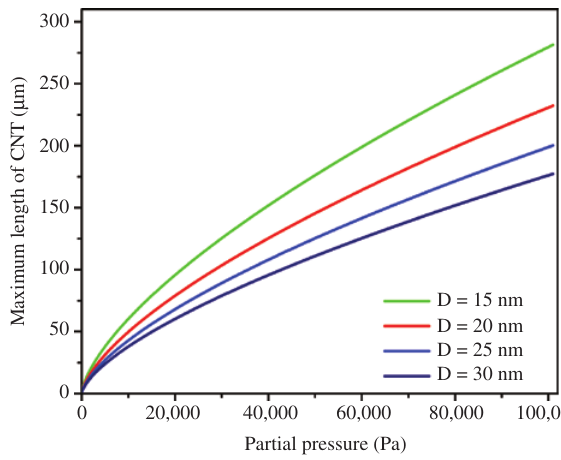
Figure 5: Variations of maximum length of CNT grown on GS versus growth temperature.